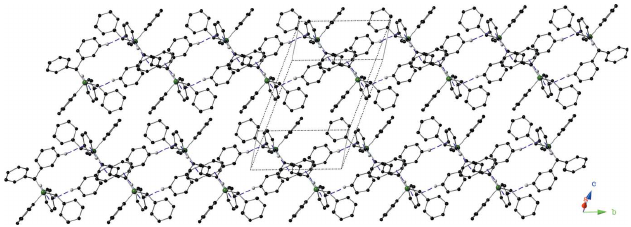
Symmetry codes: (i) (cid:4) x þ 2 ; (cid:4) y ; (cid:4) z ; (ii) (cid:4) x þ 2 ; (cid:4) y þ 1 ; (cid:4) z . Table 2 Hydrogen-bond geometry (A˚ , (cid:3) ) for II . Cg 1 is the centroid of the C4–C9 ring.